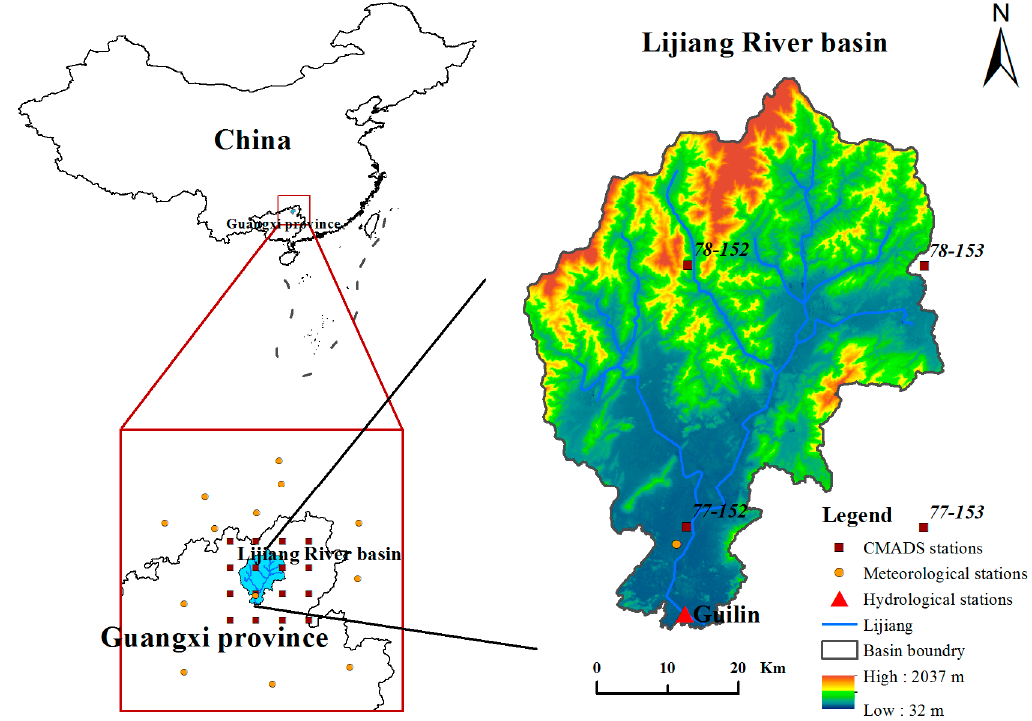
Figure 1. Location of Lijiang River basin, China and meteorological stations for the ANUSPLIN interpolation technique.